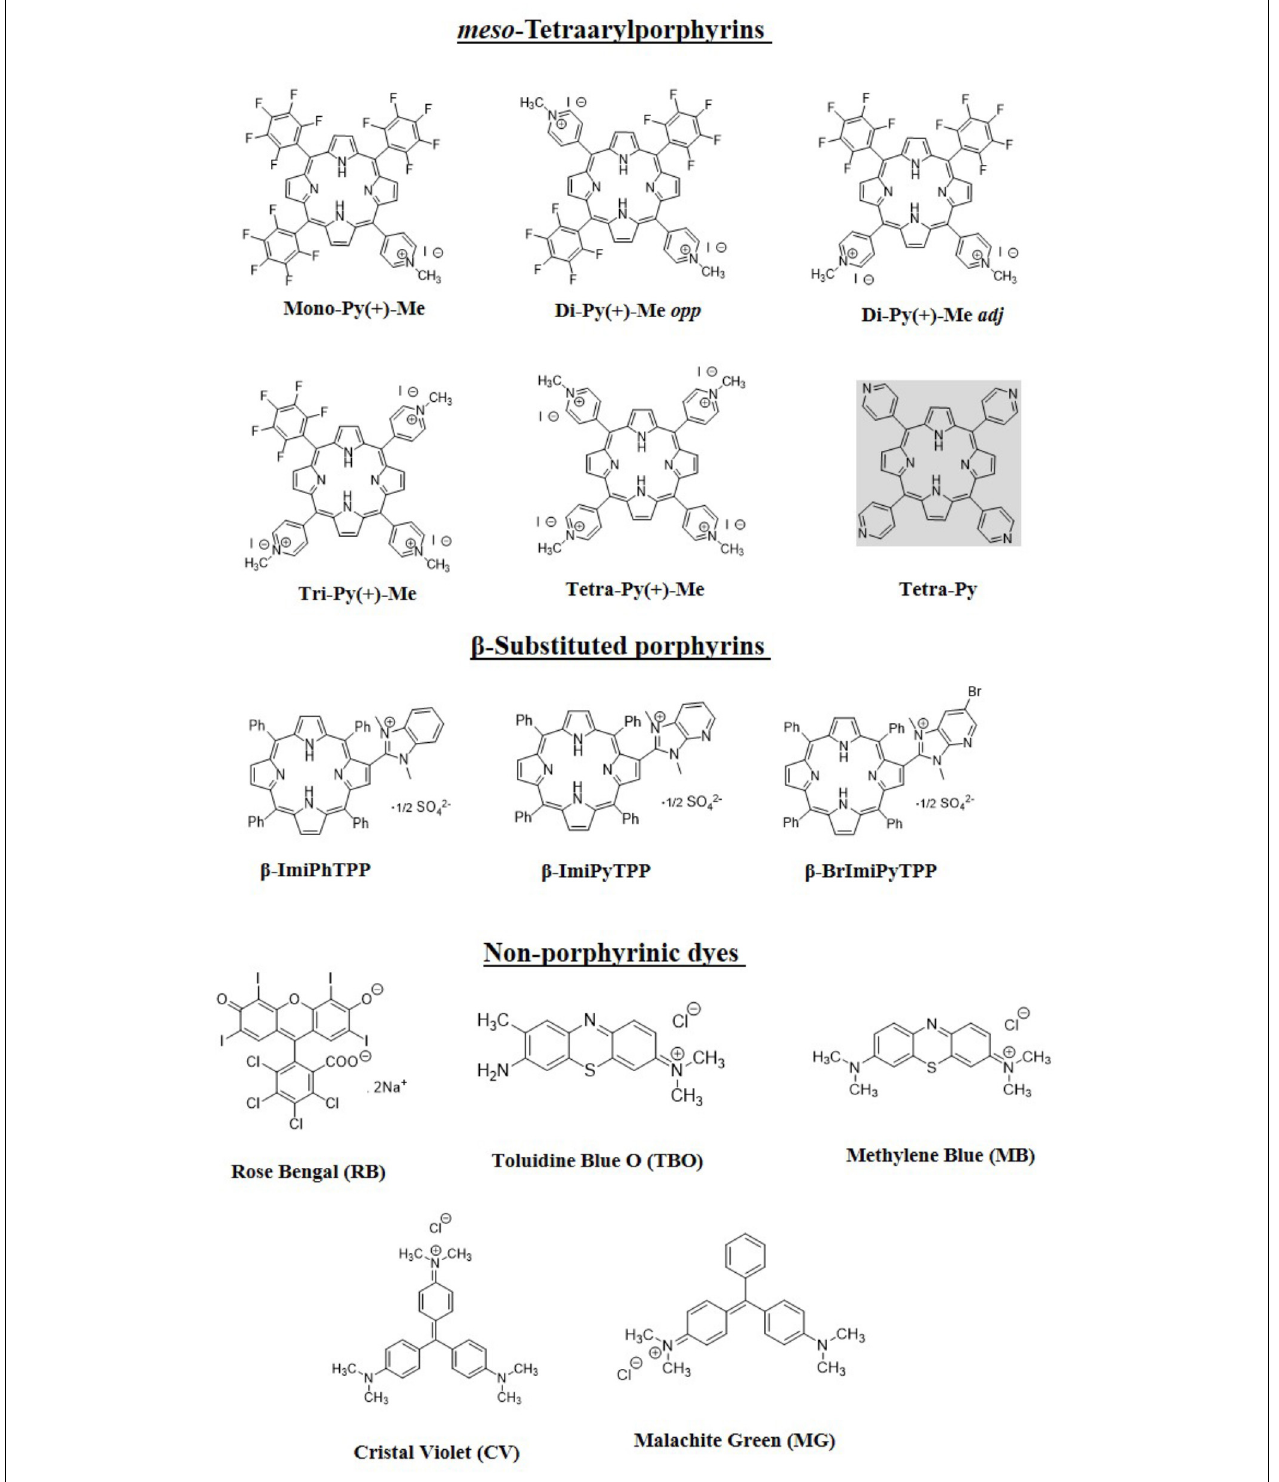
FIGURE 2 | Structures and acronyms/abbreviations of the PSs used in this study.